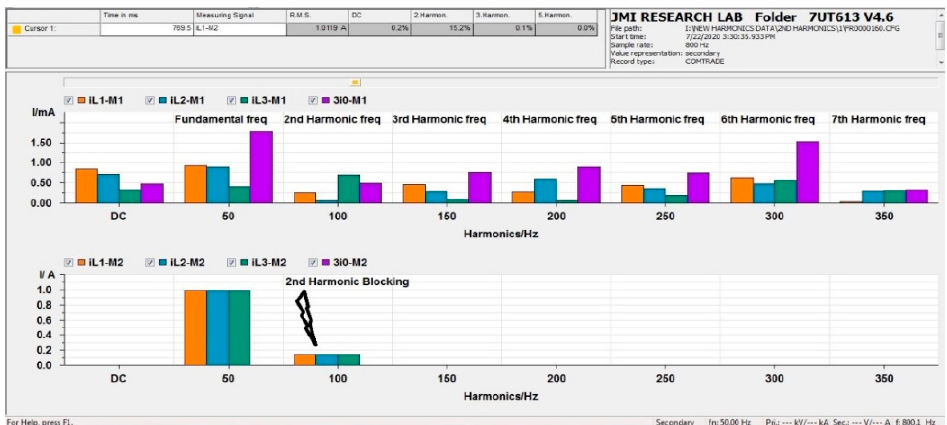
Figure 8. 2nd HB at 1000 mA Rated current & 15% of Inrush current condition.